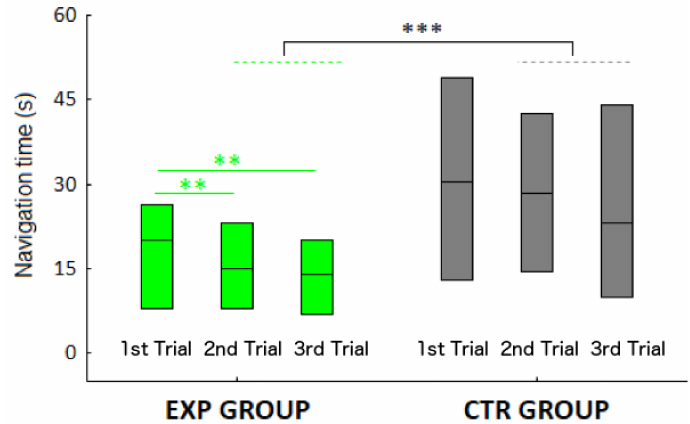
Figure 5. Navigation time (s) for each trial in the feedback group (green bars) and in the no-feedback group (grey bars). Green asterisks indicate a significant reduction of the navigation time in the 2nd and 3rd trial in the EXP group. Grey asterisks indicate a significantly slower navigation time in the 2nd and 3rd trial in the CTR compared to the EXP group. **, p < 0.01; ***, p <